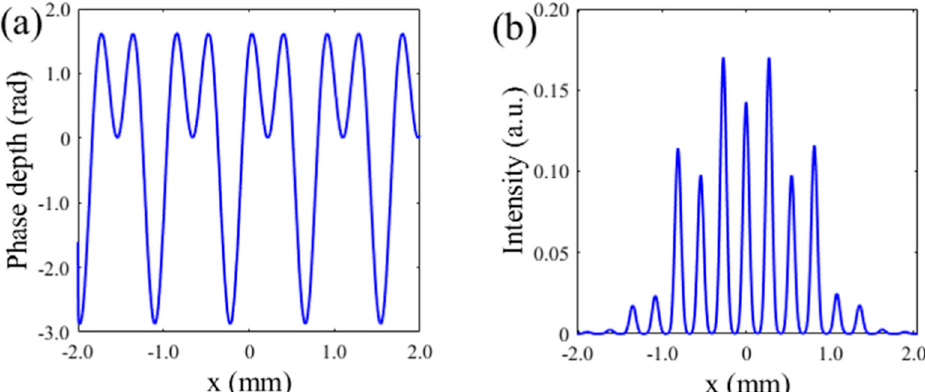
Figure 2. The hologram ( a ) and the corresponding profile of the generated spot array ( b ) based on the superposition of two sinusoid functions with different periods .